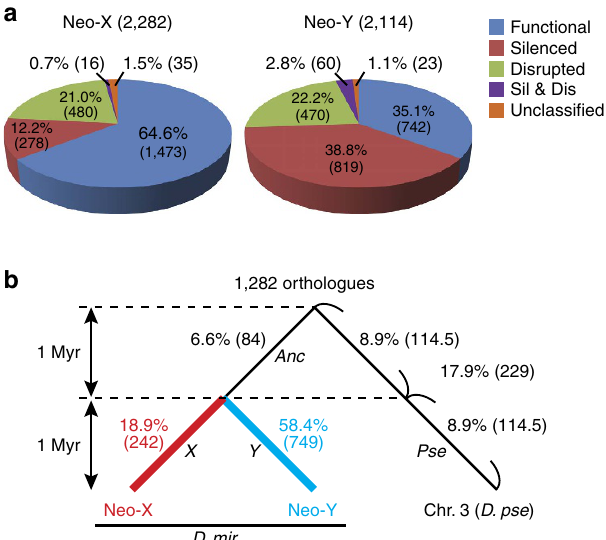
Figure 2 | Pseudogenization on the neo-X and neo-Y. ( a ) Classification of neo-X and neo-Y genes. The numbers in parentheses are the numbers of genes in each category. Blue, red, green, purple and orange colours mean functional, silenced, disrupted, silenced-and-disrupted, and unclassified genes, respectively. Silenced, disrupted, and silenced-and-disrupted genes were regarded as pseudogenes. ( b ) Proportions of genes that became pseudogenized in each evolutionary lineage. The 1,282 orthologues that are likely to be functional in D. obscura and not to have experienced any inter-chromosomal translocation after the species split from D. obscura were analysed. The D. pseudoobscura autosome that is orthologous to the neo-X and neo-Y is chromosome 3 (Muller element C). Pseudogenization events in the lineage leading to D. pseudoobscura were equally split in half assuming 2Mya for the divergence time of D. miranda - D. pseudoobscura , 1Mya for the emergence time of the neo-sex chromosomes, and a constant rate of pseudogenization in the D. pseudoobscura lineage.